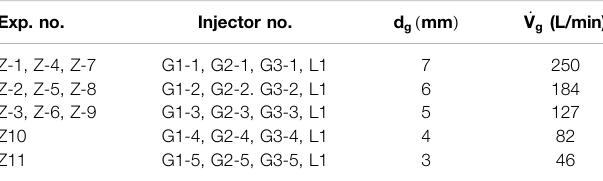
TABLE5| Workingconditionsforthedifferentself-oscillationcharacteristicsofthe coaxial injectors. Exp. no. Injector